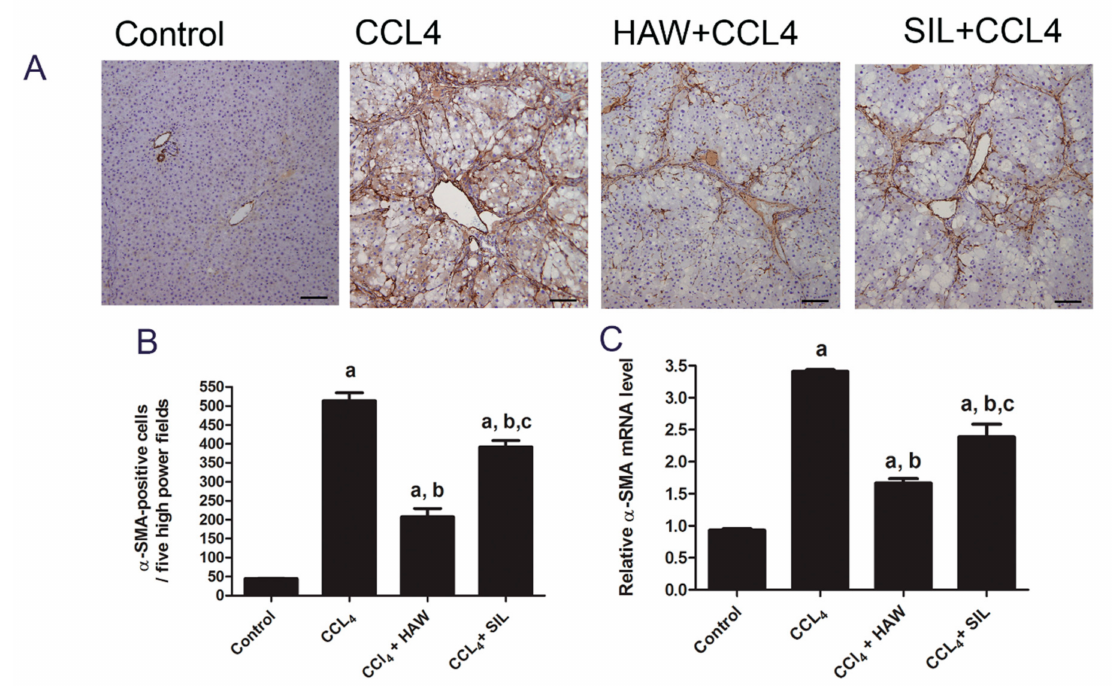
Figure 3. E ff ects of HAW on the CCl4-induced hepatic stellate cells (HSC) activation in liver fibrosis model. HAW inhibited HSC activation in liver fibrosis. ( A ) representative images of immunohistochemically expression of α -SMA in the liver was determined by immunohistochemistry (brown area), 100 × magnification, scale bar equals 100 µ m. In CCL4 section marked staining for alpha-smooth muscle actin ( α -SMA) is found along with the fibrous septa. ( B ) the expression of α -SMA cells in each section was calculated by counting the number of brown staining, α -SMA-positive cells in five fields per section at 400 × magnification, n = 6 per group). ( C ) the mRNA expression levels of α -SMA were detected by q-RTPCR. Data are presented as means ± SEM, n = 3 per group. a is p < 0.05 vs. control group, b is p < 0.05 vs. CCl4 group, and c is p < 0.05 vs. HAW